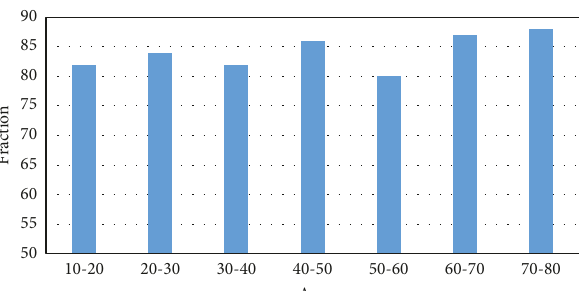
Figure 12: The scoring results of this experiment at different ages in city